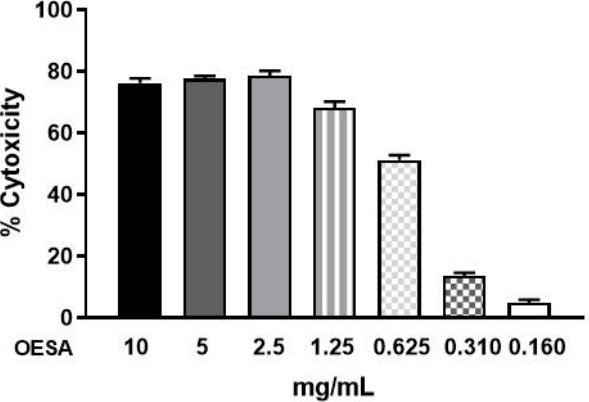
Figure 3. Cytotoxicity effect of OESA in Raji cells. Raji cells (6 × 10 4/ well) were exposed to serial dilutions of OESA (0.16 mg/mL, 0.31 mg/mL, 0.625 mg/mL, 1.25 mg/mL, 2.5 mg/mL, 5 mg/mL, 10 mg/mL) for 72 h and further incubated with MTT solution in dark for 4 h. The absorbance was measured at 570 nm and the % of cytotoxicity was calculated. Results were expressed as mean ± standard deviations (n =